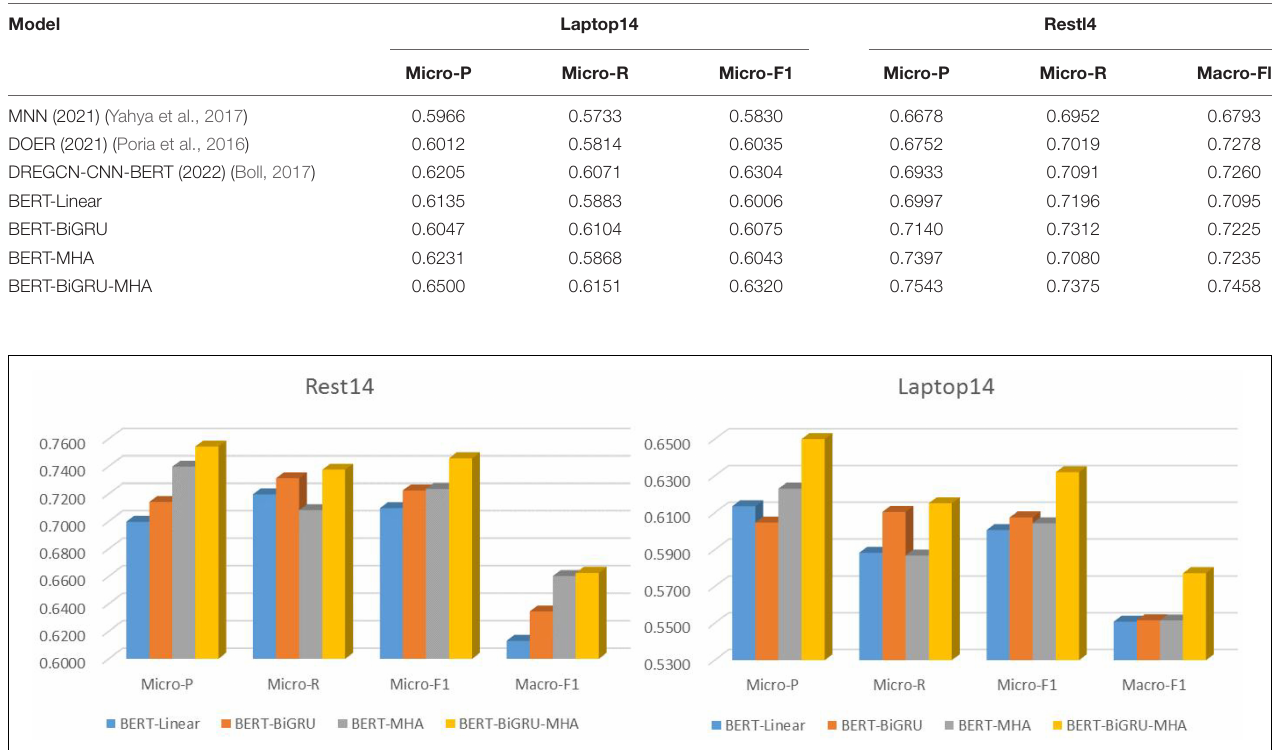
TABLE 6 | Primary experimental results of each model on the Laptop14 and Rest14 datasets.